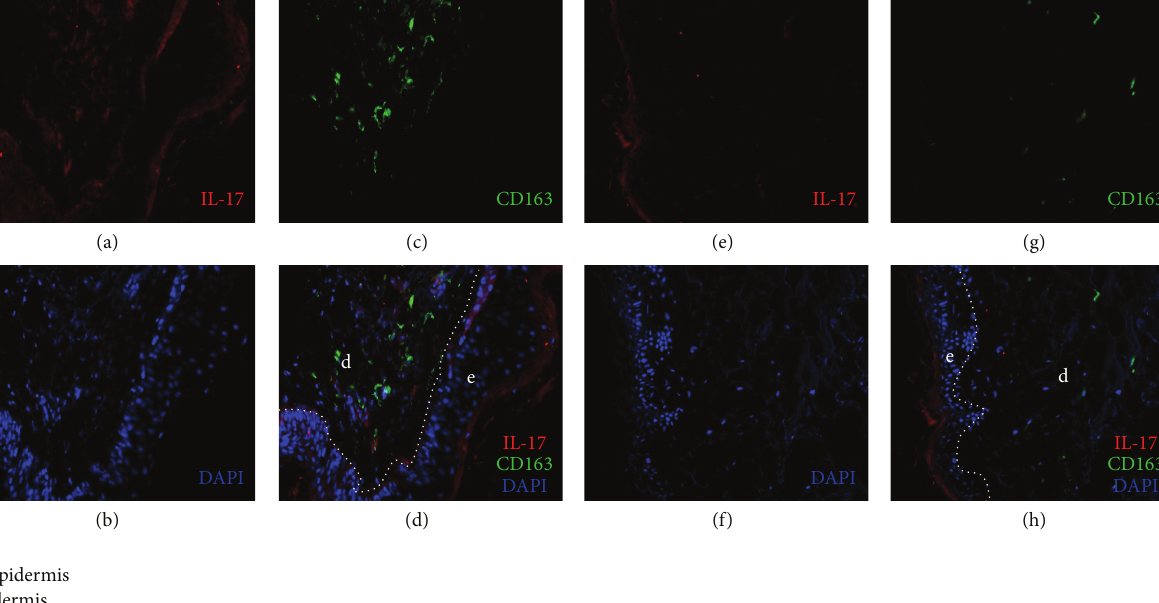
Figure 2: Immunofluorescence studies of lesional skin specimens (a–d) and control skin specimens (e–h). The red and green stained cells were detected by antibodies to IL-17 and CD163,